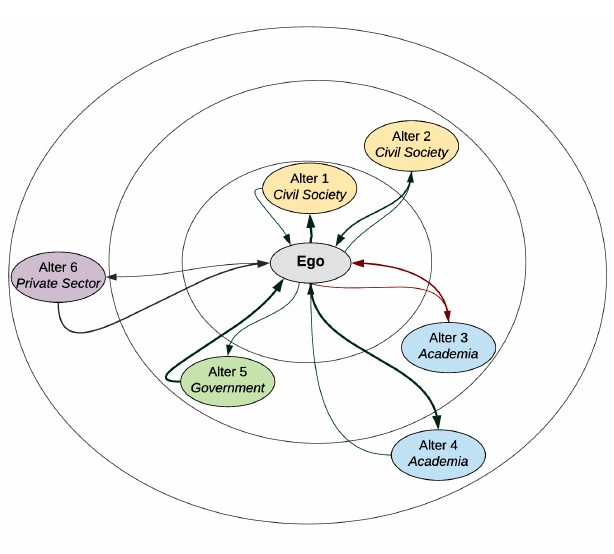
Fig. 1. Example of an